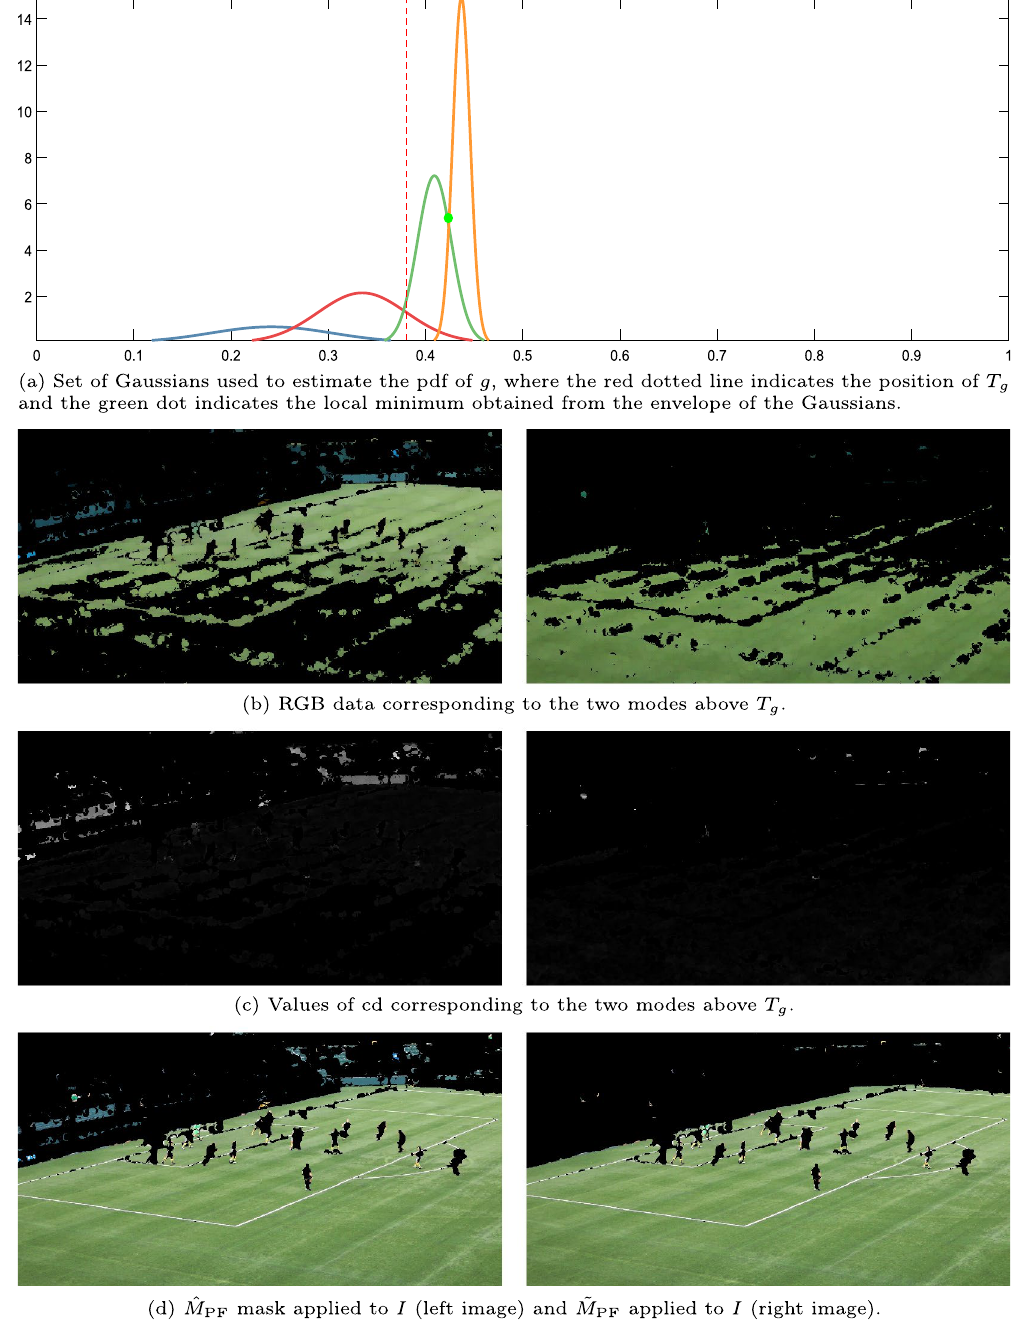
Figure 5. Example of the quality improvement obtained with the chromatic distortion analysis. Results corresponding to the original image from 48